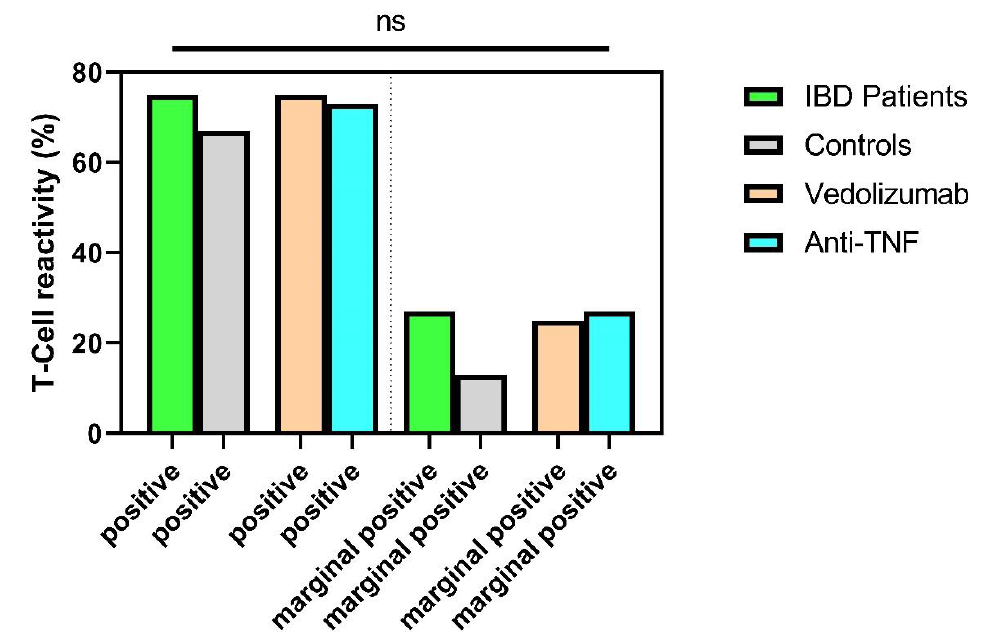
Figure 4. SARS-CoV-2-specific T-cellular reactivity (in%) of IBD patients and healthy controls six months after the second vaccination. Subdivision into positive T-cellular reactivity and marginally positive T cellular reactivity. ns, not significant. Categorical variables were compared using the chi-square test or Fisher’s exact test.